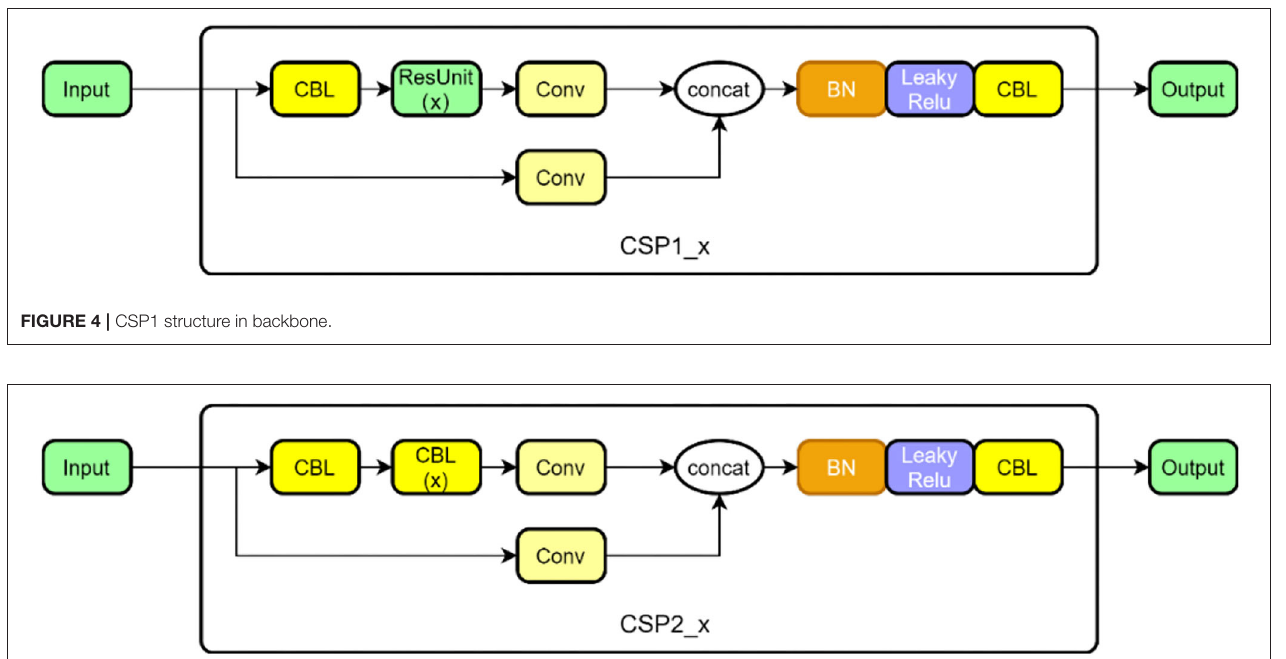
FIGURE 5 | CSP2 structure in the feature analysis